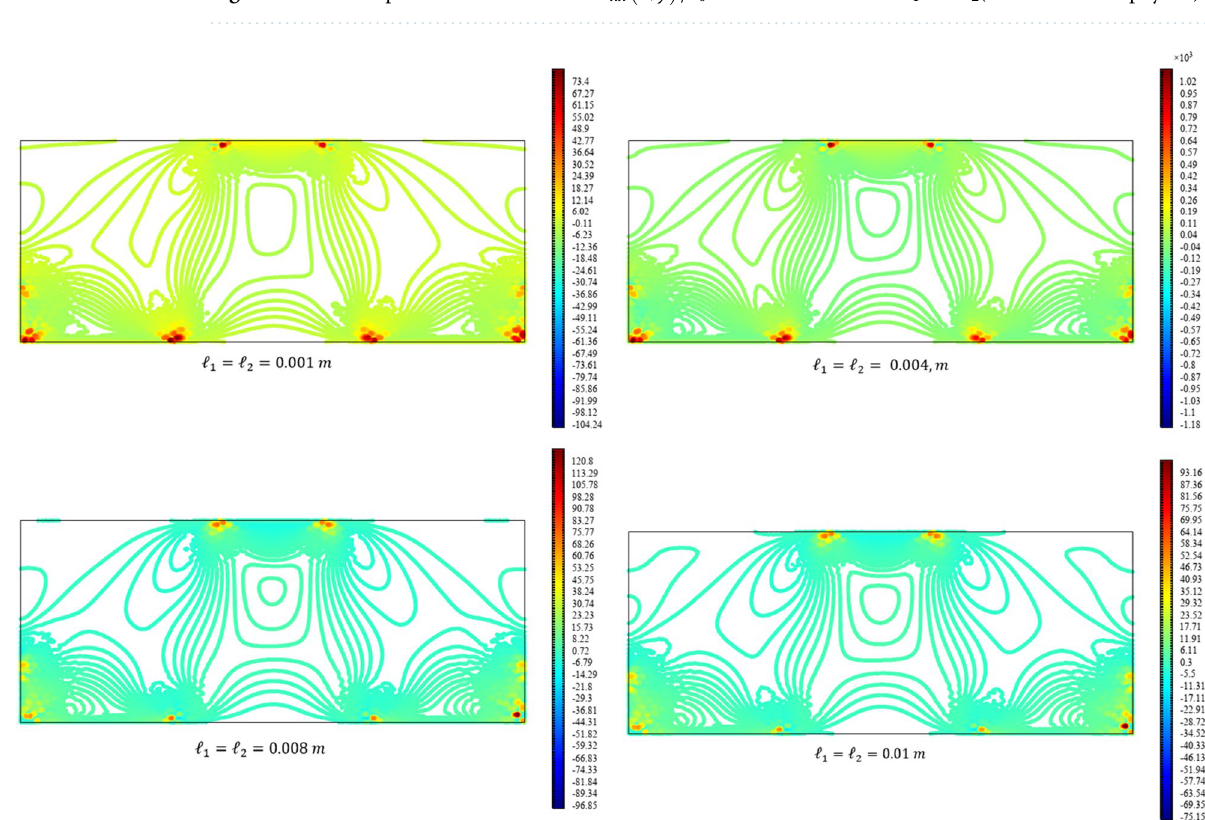
Figure 6. Contour plot for the micro-strain s